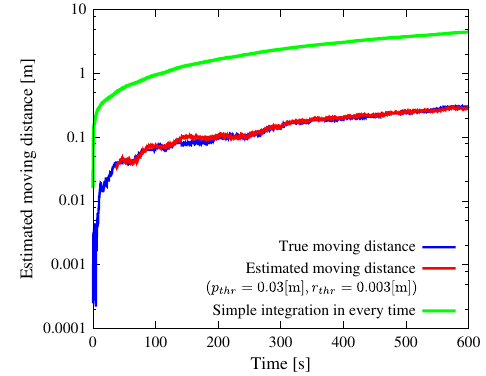
Figure 4: Location estimation accuracy.